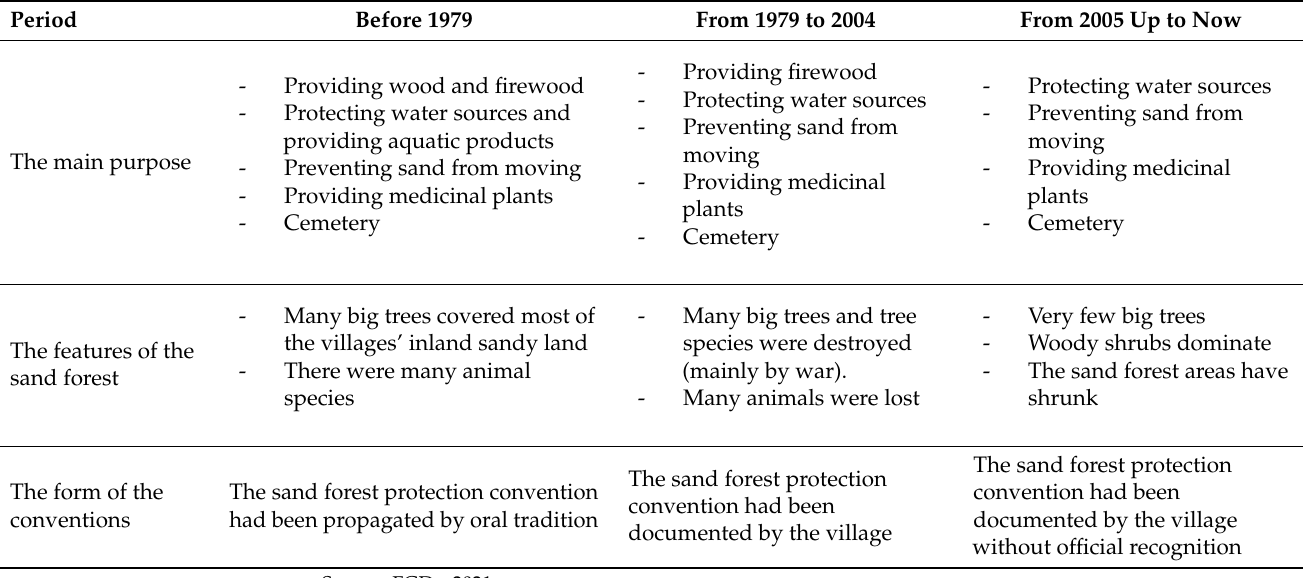
Table 2. The changes in the sand forest’s roles in the studied